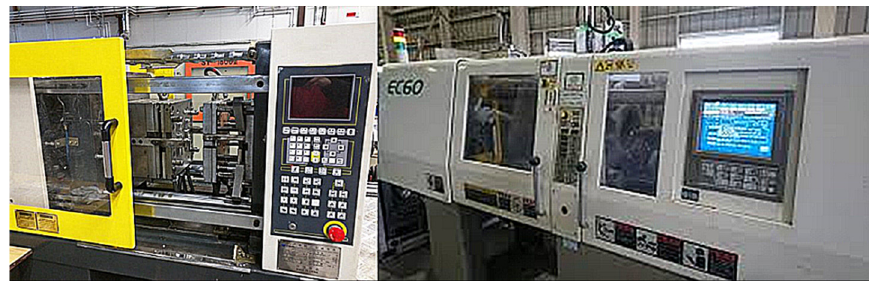
Figure 1. Plastic injection machines.